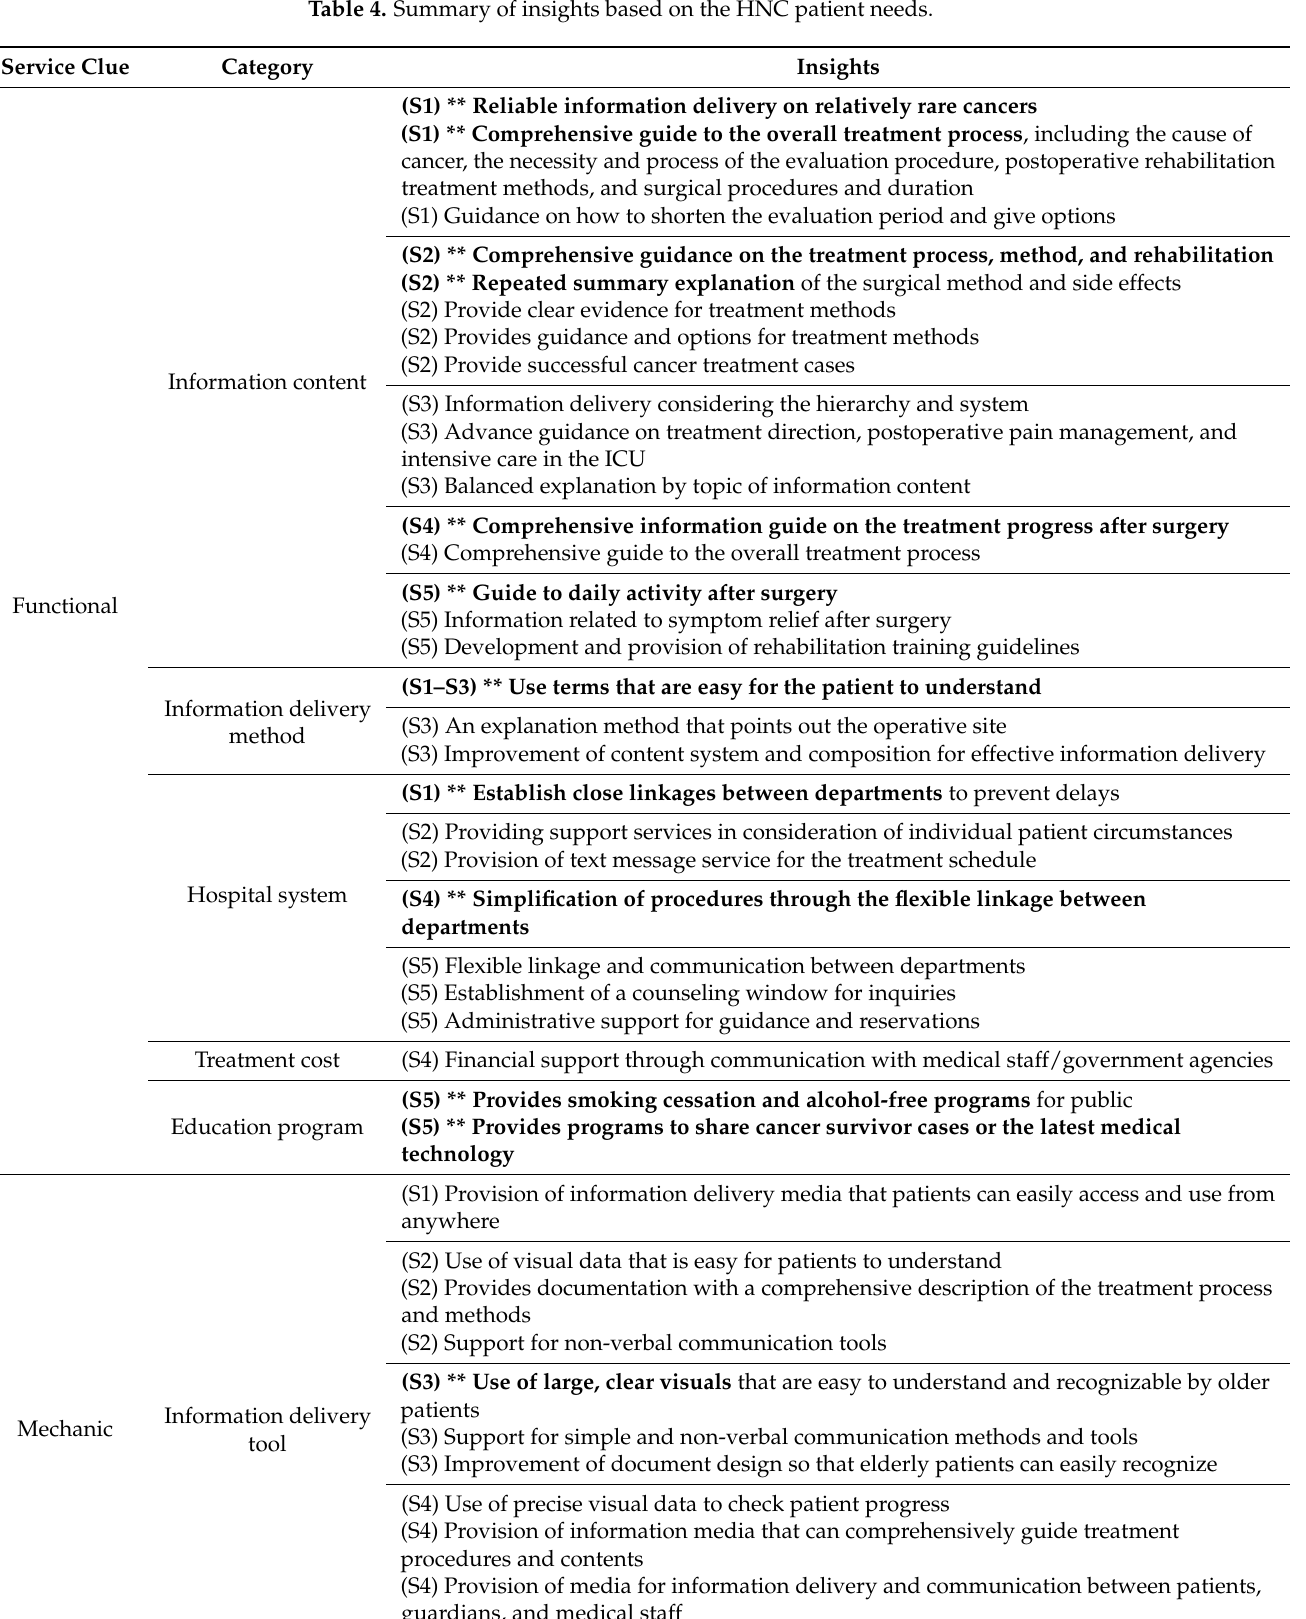
Table 4. Summary of insights based on the HNC patient